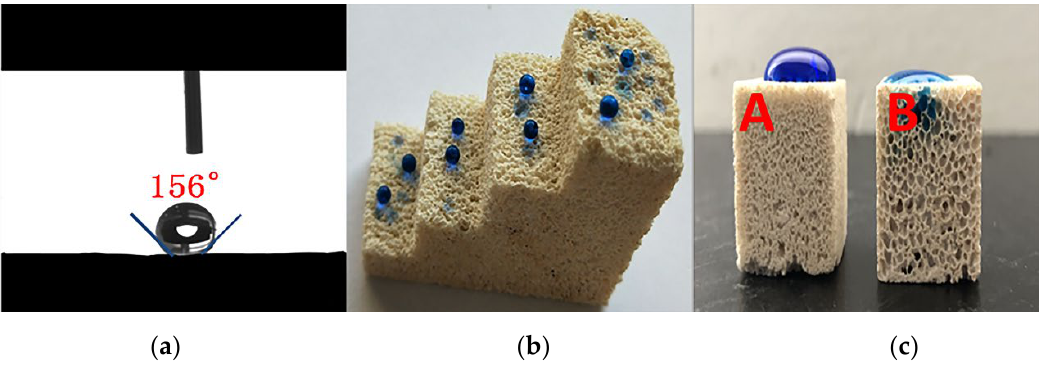
Figure 10. F-MOC hydrophobic effect: ( a ) is the water contact angle test graph, ( b ) is the overall hydrophobic effect graph of F-MOC, and ( c ) is the comparison graph of F-MOC and N-MOC.